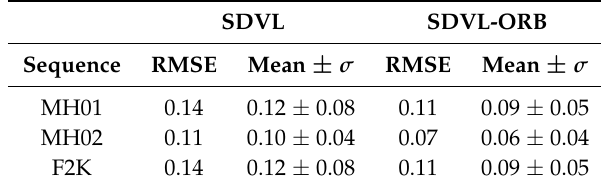
Table 1. SDVL accuracy.